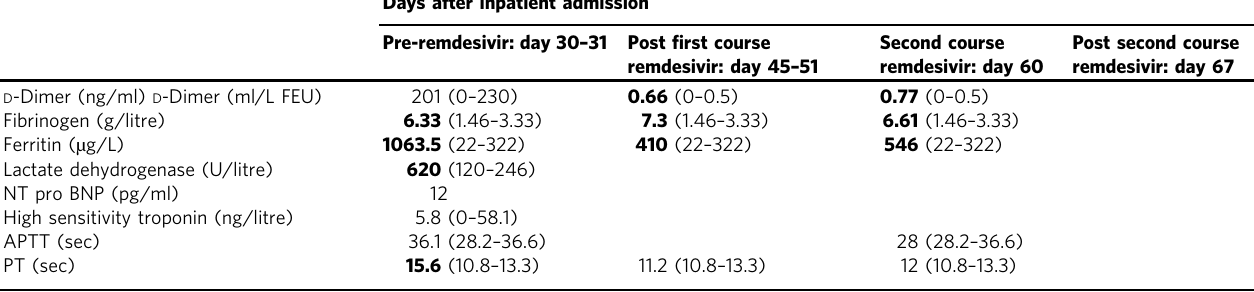
Abnormal results are shown in bold. Numbers in parentheses indicate reference values of the corresponding measurements. APTT activated partial thromboplastin time, PT prothrombin